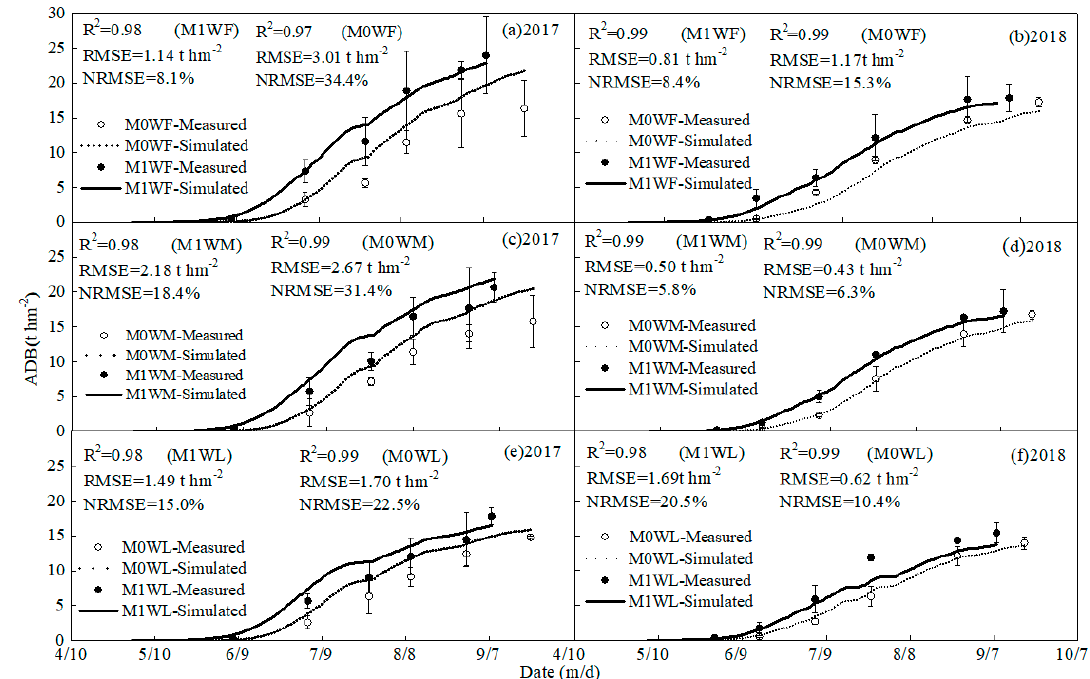
Figure 5. Comparison of the simulated and measured aboveground dry biomass (ADB) under di ff erent treatments during the entire growing season of 2017 ( a , c , e ) and 2018 ( b , d , f ). Table 8. Comparison of the simulated and measured seed-maize yield, total evapotranspiration (ET), and water use e ffi ciency (WUE) under di ff erent treatments in 2017 and 2018.